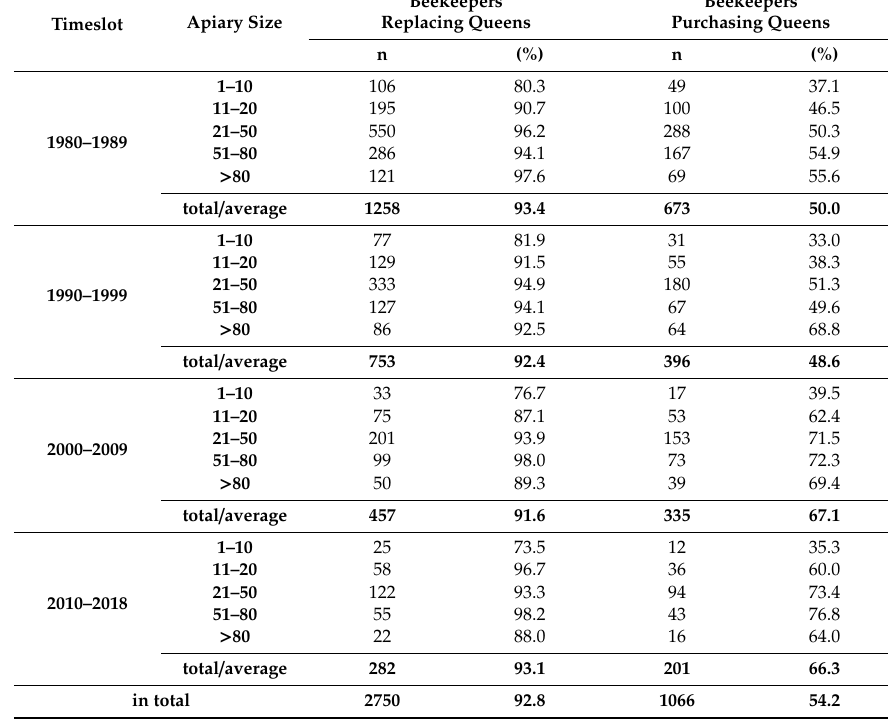
Table A1. Numerical characteristics of beekeepers replacing queens in their apiaries, including those who introduced purchased queens, analyzed by decade timeslot and apiary